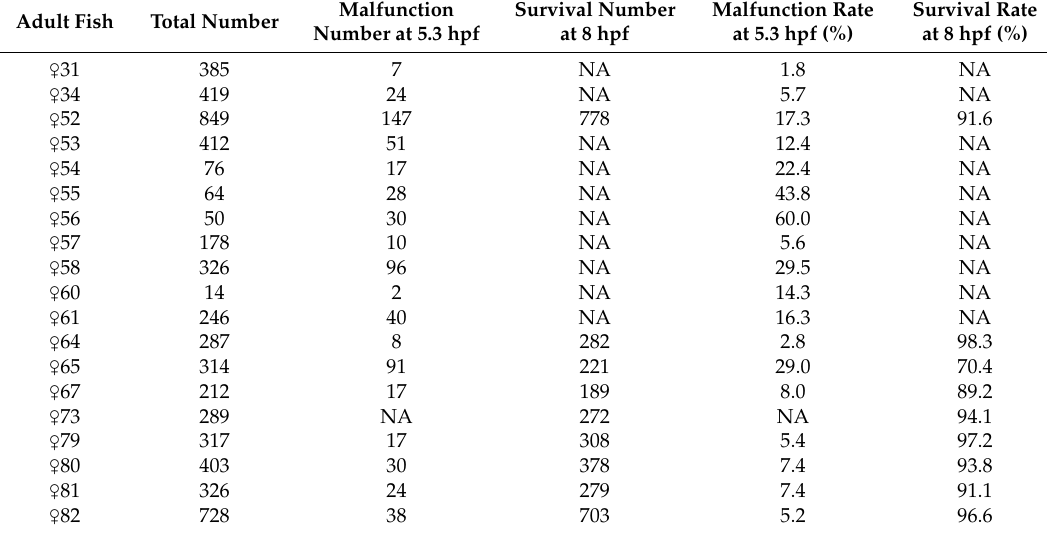
Table 1. Survival and malfunction rate of topirmate-treated offspring. Female zebrafish were continuously oral-fed with topiramate for 7 days. At the end of the final day of drug feeding, we set up a breeding environment and collected embryos the following morning and monitored the malfunction and survival that showed aberrant epiboly and early death at 5.3 and 8 hpf, respectively. Individual malfunction or survival number/total number of embryos from 19 different female zebrafish presented as individual malfunctions and survival rates. (NA: not available; hpf: hour post fertilization.)